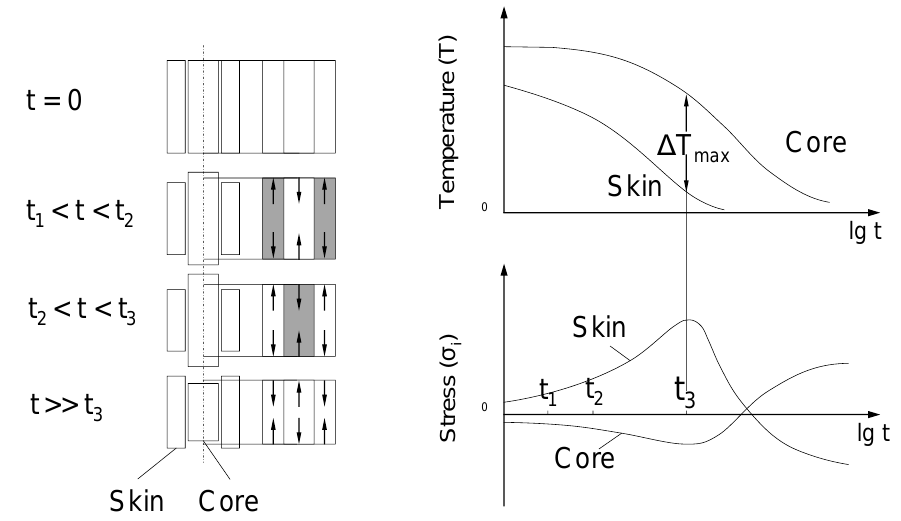
Figure 5. Tension conversion and formation of residual stresses [1].